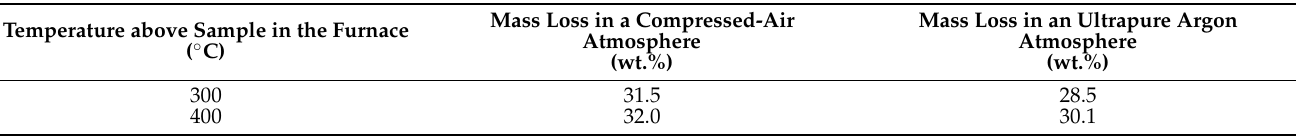
Table 1. Observed WEEE samples’ mass loss after thermal processing in a tubular furnace as a function of the temperature and the atmospheric chemical composition.